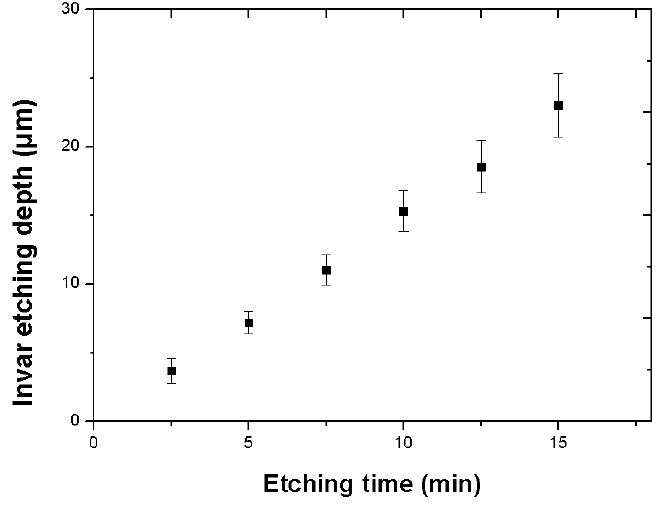
Figure 6. Invar film single side wet etching material removal rate.